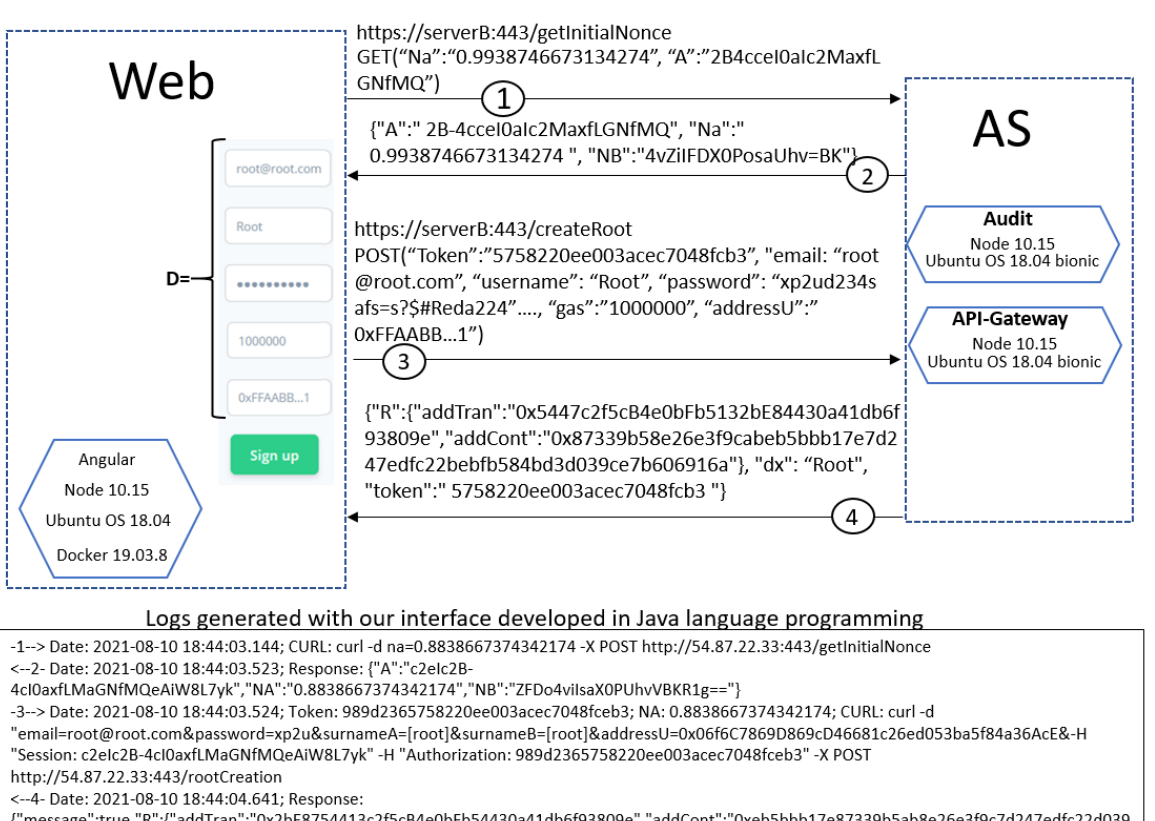
Figure 8. The complete protocol without